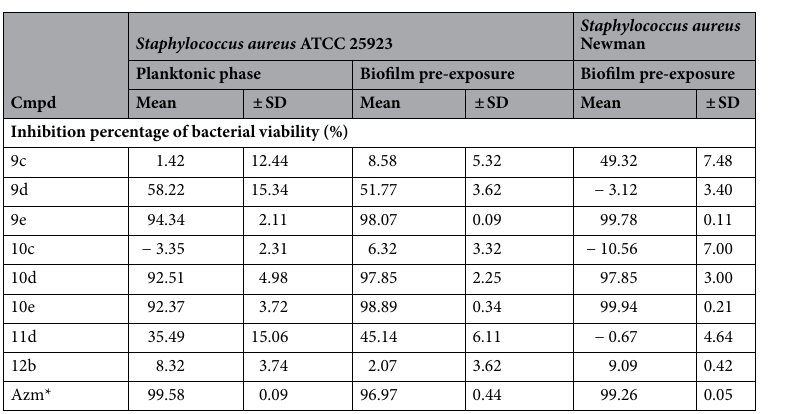
Table 1. Antimicrobial activity of the second set of 2,4,5,6-tetrasubstituted pyrimidines, including the most active compounds identified in the previous screenings against S. aureus ATCC 25923 and Newman clinical strains. All compounds were tested at 100 µM. Results are expressed as the mean value ± standard deviation (SD) for three parallel replicates and two biological repetitions. *Azithromycin (azm), the antibiotic used as the positive control, was tested at 400